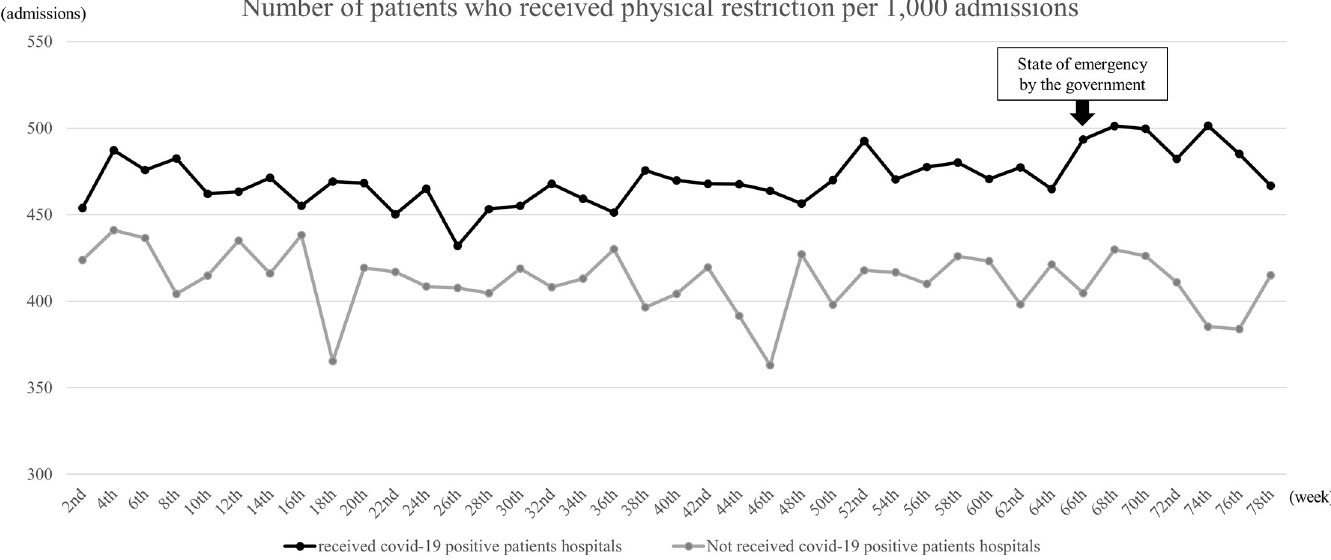
Fig 2. Comparison of the number of patients restrained between the two groups. The number of patients physically restrained per 1,000 hospital admissions for 2-week intervals between January 1, 2019, and June 30, 2020, in the two groups.